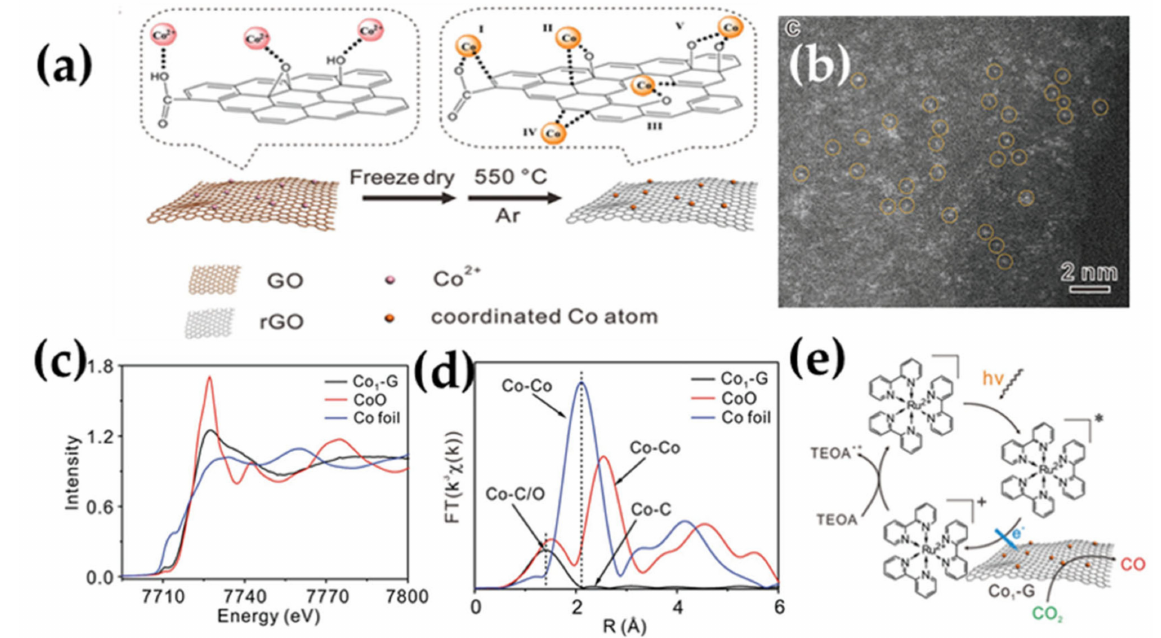
Figure 5. ( a ) Schematic illustration of the synthetic procedure for the Co 1 –G catalyst [75]; ( b ) HAADF-STEM image of the Co 1 –G catalyst. The atomically dispersed Co atoms are highlighted by the yellow circles [75]. ( c ) Normalized Co K-edge XANES spectra of the Co 1 –G sample in reference to Co foil and CoO [75]; ( d ) k 3 -weighted Fourier-transform Co K-edge EXAFS spectra [75]; ( e ) Schematic illustration of the process for photocatalytic reduction of CO 2 to CO using [Ru(bpy) 3 ]Cl 2 as a light absorber and Co 1 –G nanosheets as a catalyst